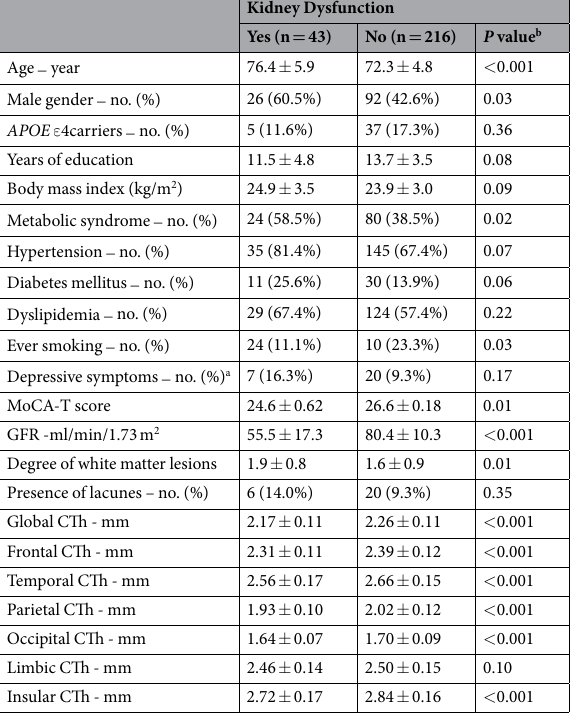
Table 1. Characteristics of the study participants according to the status of kidney dysfunction. Data are presented as mean ± standard deviation. a Depressive symptomsare defined as scores 16 or higher on Center